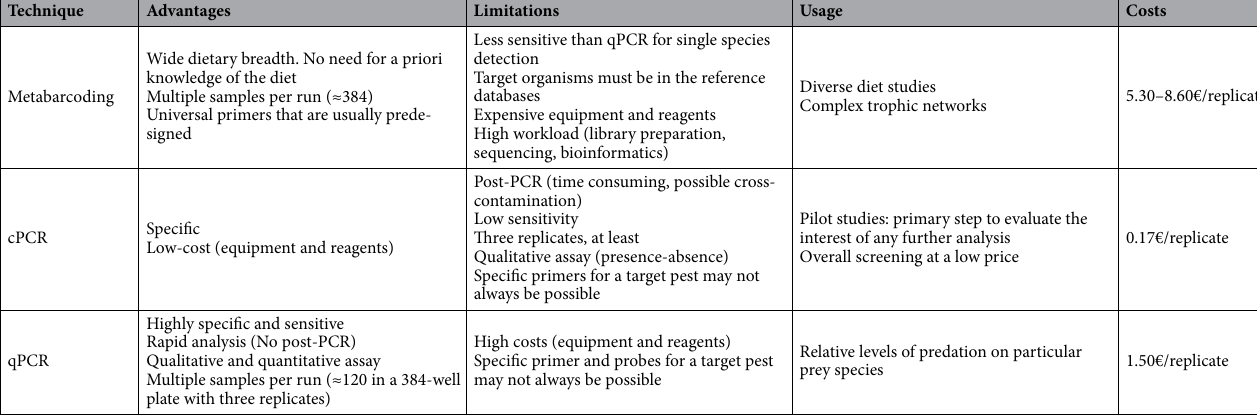
Table 2. Advantages, limitations, usage and costs of the molecular techniques used in the